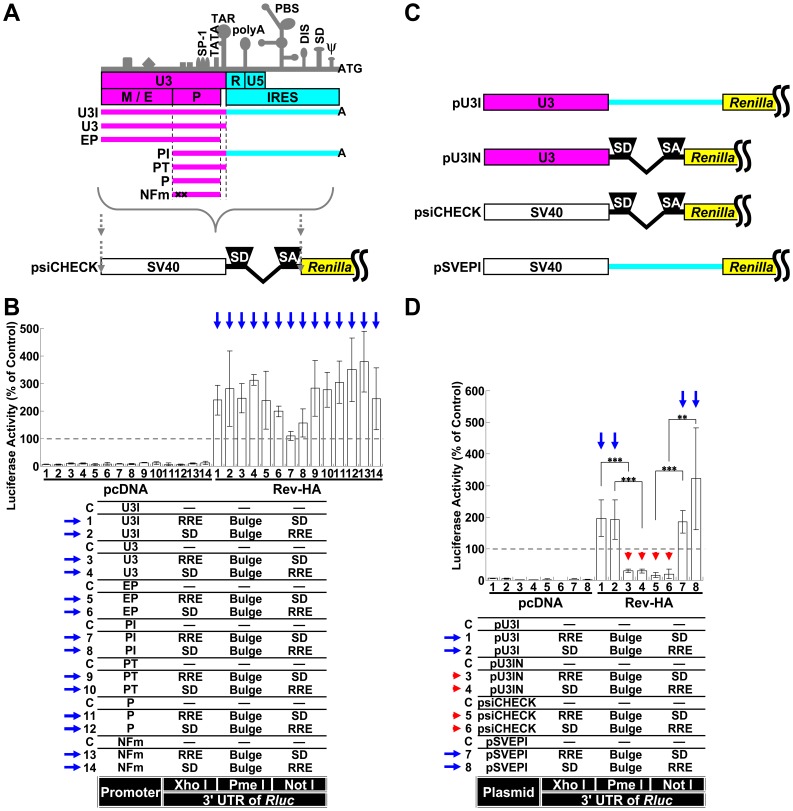
Silencing of RNAs transcribed from the HIV-1 LTR.(A) A schematic of the HIV-1 LTR. The important transcriptional elements in the U3 region, characteristic secondary structures and major functional regions are shown. “M/E” indicates the modulator and enhancer regions, and “P” indicates the promoter region. Several truncated promoters, U3I, U3, EP, PI, PT, P and NFm, which is identical to P but carries mutations in the two NF-κB binding sites that render them nonfunctional, were generated as shown. The SV40 promoter and intron region of the psiCHECK were replaced with various regions of the LTR. (B) The RNAs transcribed by promoters derived from several regions of the HIV-1 LTR were exported by Rev-HA and analyzed to determine the effects of miRNA-mediated interference. The blue arrow points to the Bulge-containing constructs that carry a correctly oriented RRE and were not silenced in the presence of Rev-HA. (C) The schematics of the pU3I, pU3IN, psiCHECK and pSVEPI constructs. In the pU3IN and pSVEPI constructs, the region downstream of the TAR (light blue region) of pU3I and the region containing the chimeric intron from the psiCHECK were exchanged with each other. (D) The effects of splicing on miRNA-mediated silencing were analyzed using chimeric promoters derived from the LTR and SV40 promoters. The red arrowhead points to the Bulge-containing constructs that carry an intron and a correctly oriented RRE and were silenced in the presence of Rev-HA. The blue arrow points to the Bulge-containing constructs without an intron that carry a correctly oriented RRE and were not silenced in the presence of Rev-HA. The Renilla/firefly luciferase value was assessed in each graph. The empty vector C was used as a control in each promoter setting, and the results are presented as the mean ± S.D. as a percentage of the control from three independent experiments. “pcDNA” denotes the pcDNA3.1(+) plasmid. ***P<0.001, **P<0.005.